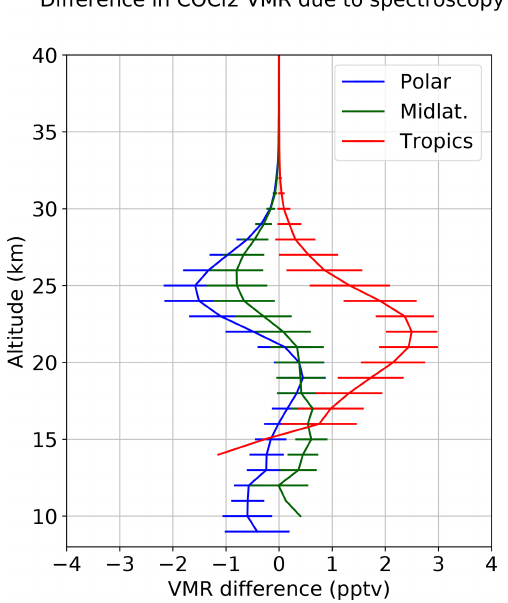
Figure 7. Average differences between COCl 2 retrieved by ORM v8 using the spectroscopic database described in Gordon et al. (2017) and in Brown et al. (1996). The average was computed us- ing the scans of one orbit of OR measurements, grouped into three latitude bands as described in the label of the figure. The error bars are the errors of the